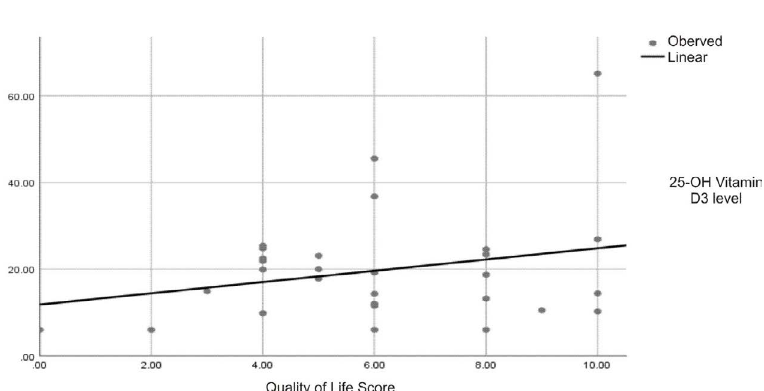
Fig. 3. Correlation between 25-hydroxyvitamin D3 level and quality of life score in patients with multiple